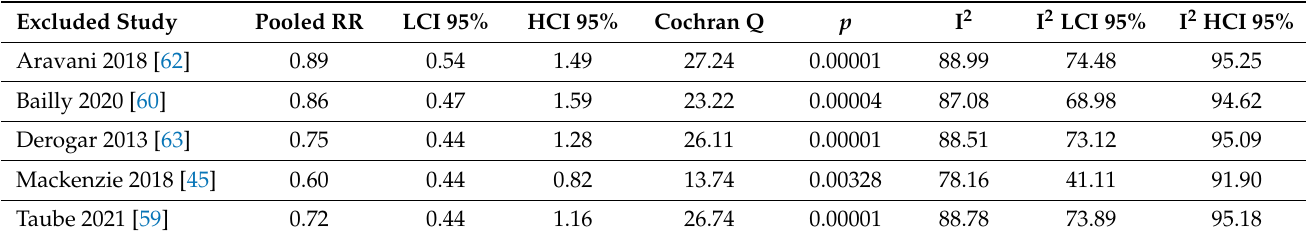
Figure A12. Oesophageal random e ff ects model funnel plot.